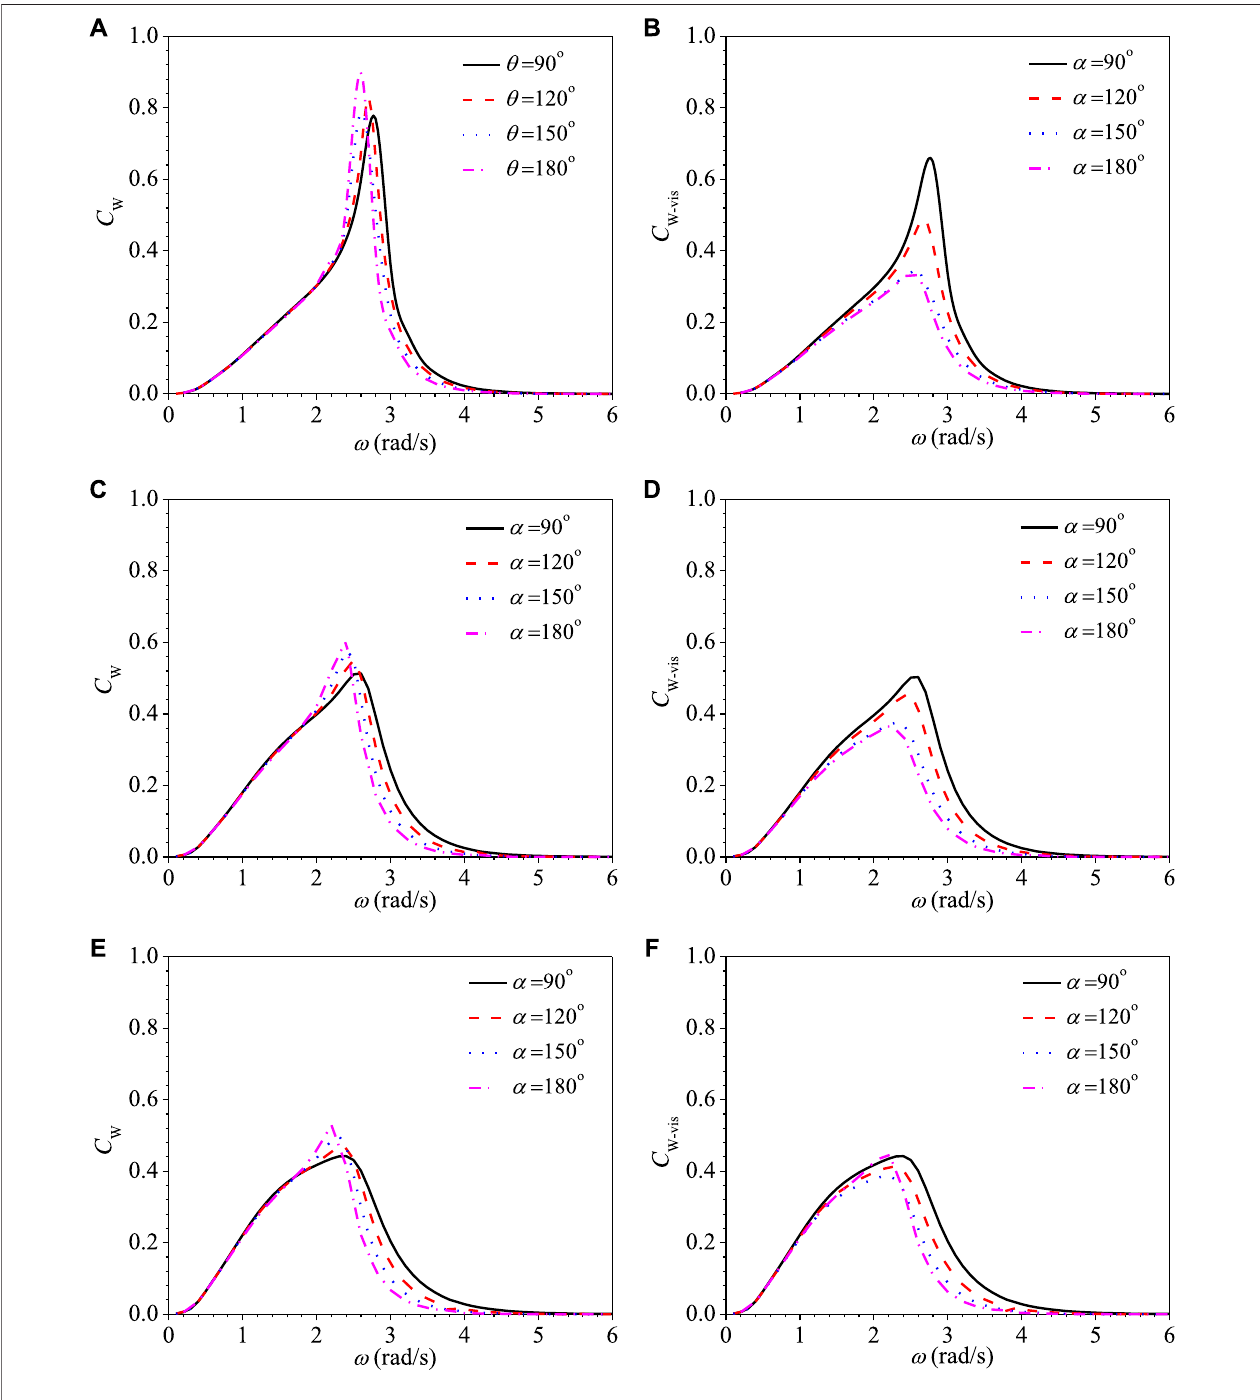
Figure5| VariationsofCWR C W vs. ω fortheconebottomcylindricalWECwithdifferent2 r / d . (A) C W at2 r / d (cid:2) 1.6, (B) C W-vis at2 r / d (cid:2) 1.6, (C) C W at2 r / d (cid:2) 2.8, (D) C W-vis at 2 r / d (cid:2) 2.8, (E) C W at 2 r / d (cid:2) 1.6, and (F) C W-vis at 2 r / d (cid:2) 1.6.